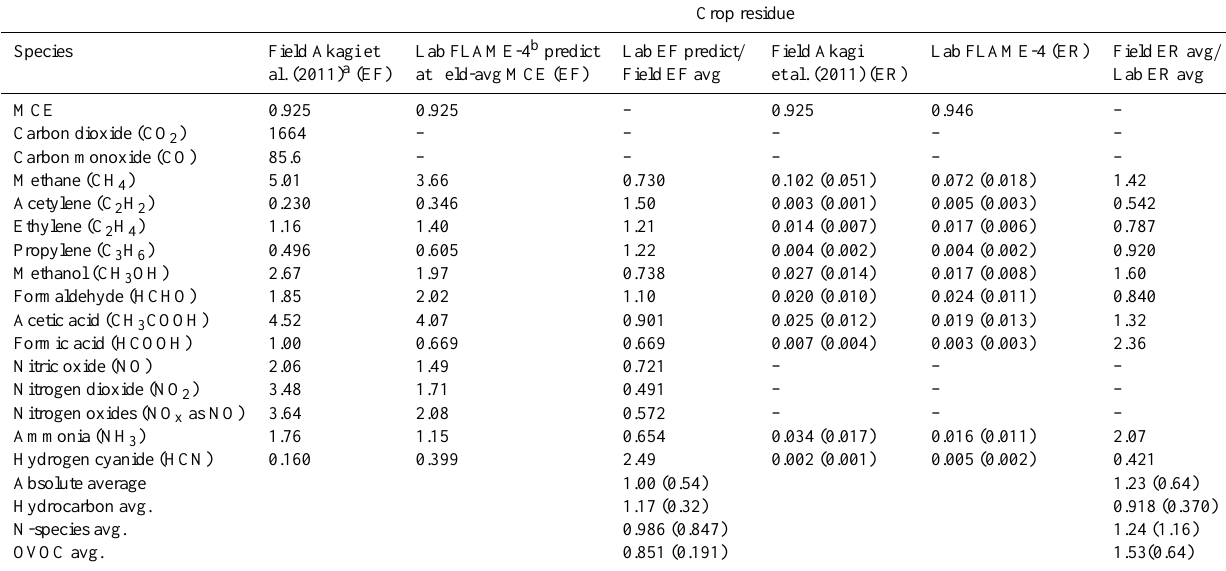
Table 5. Summary of the comparison of emission factors and emission ratios (to CO) measured in the lab and field for crop residue fuels. Values in parentheses are one standard deviation.